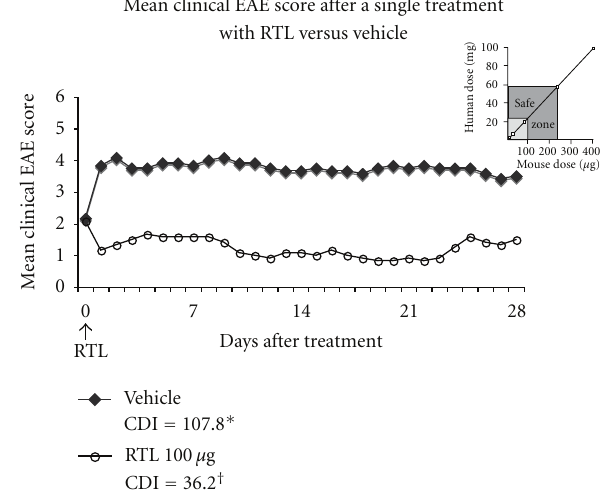
Figure 3: Mouse MOG homologue of RTL1000 treats EAE in DR2 transgenic mice. HLA-DR2 mice were immunized with mouse (m)MOG-35-55 peptide + CFA + Ptx to induce EAE and were treated IV with a single dose of 100 μ g of the mouse (m)MOG homologue of RTL1000 (DR2/mMOG-35-55 peptide) or bu ff er at onset of clinical signs of EAE (indicated as Day 0, corresponding to ∼ Day 10 after immunization). The mice were scored daily for 28 days for clinical signs of EAE ( n = 5 mice/group). Reduction in daily scores and cumulative disease scores in RTL versus vehicle- treated mice was significant ( ∗ P < 0 . 05; † P < 0 . 01, resp.). Inset. Dose comparisons in mice versus humans based on body surface area. Note that the 100 μ g dose that is highly e ff ective at treating EAE in mice is equivalent to a ∼ 25 mg dose in humans, well within the safe dose range determined in our study. Figure reproduced in part from O ff ner et al.